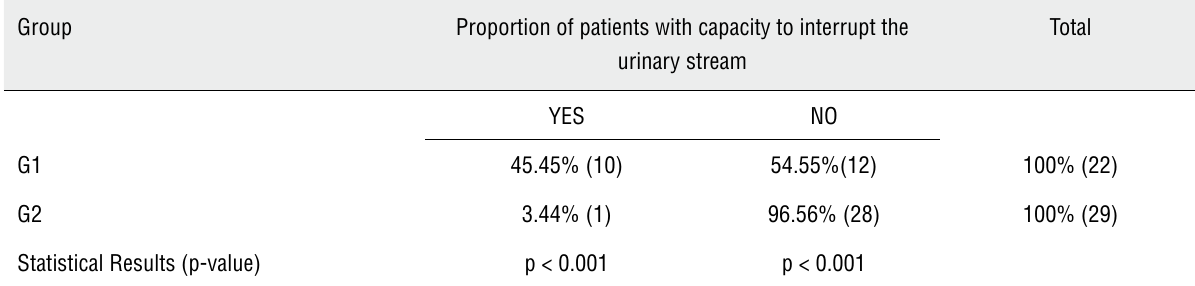
Table 2 - Assessment of pelvic floor performance with stream interruption test expressed in proportional value. Group